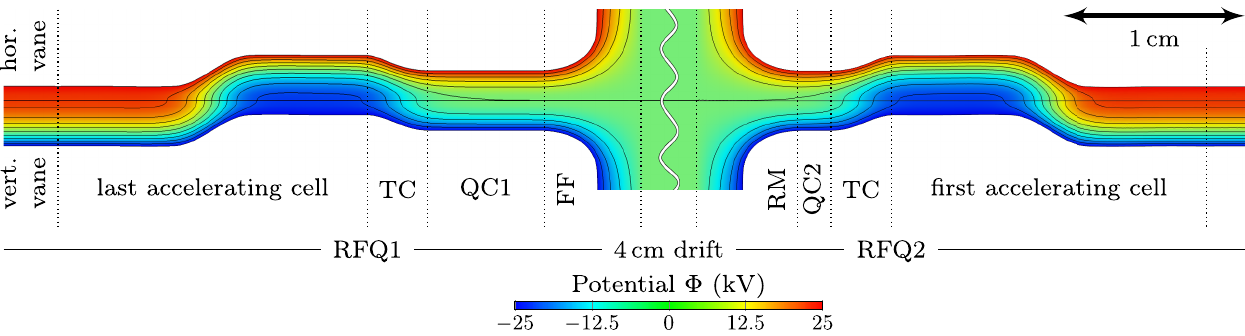
FIG. 21. Field map of the lattice used to transfer the beam from the last accelerating cell of RFQ1 to the first accelerating cell of RFQ2. Both horizontal plane (upper half) and vertical plane (lower half) are shown. After the transition cells (TC), the vanes are extended by the quadrupole cells QC1 and QC2, whose lengths is chosen such that the envelope oscillation in RFQ2 is